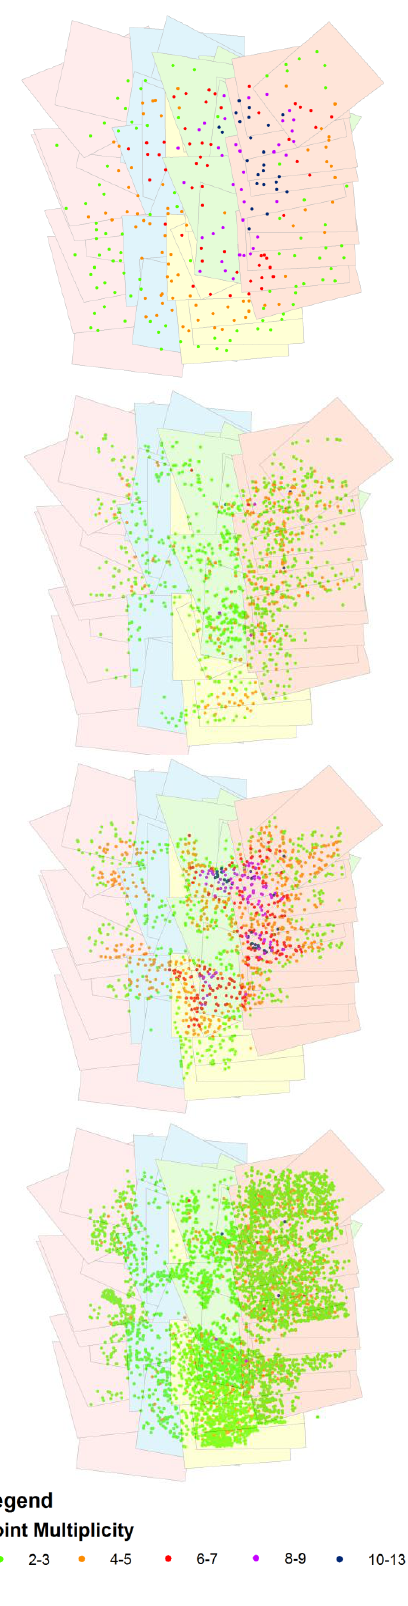
Figure 3 – Tie points distribution on the images for the different software: from top to bottom LPS, EyeDEA, P4, AP